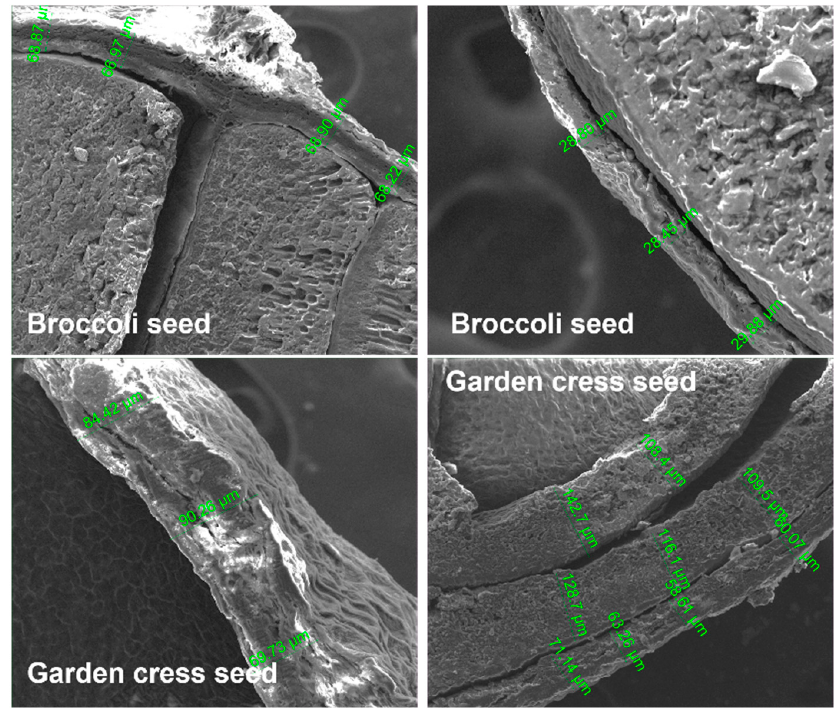
Figure 6. ESEM images of seed section for broccoli and garden cress